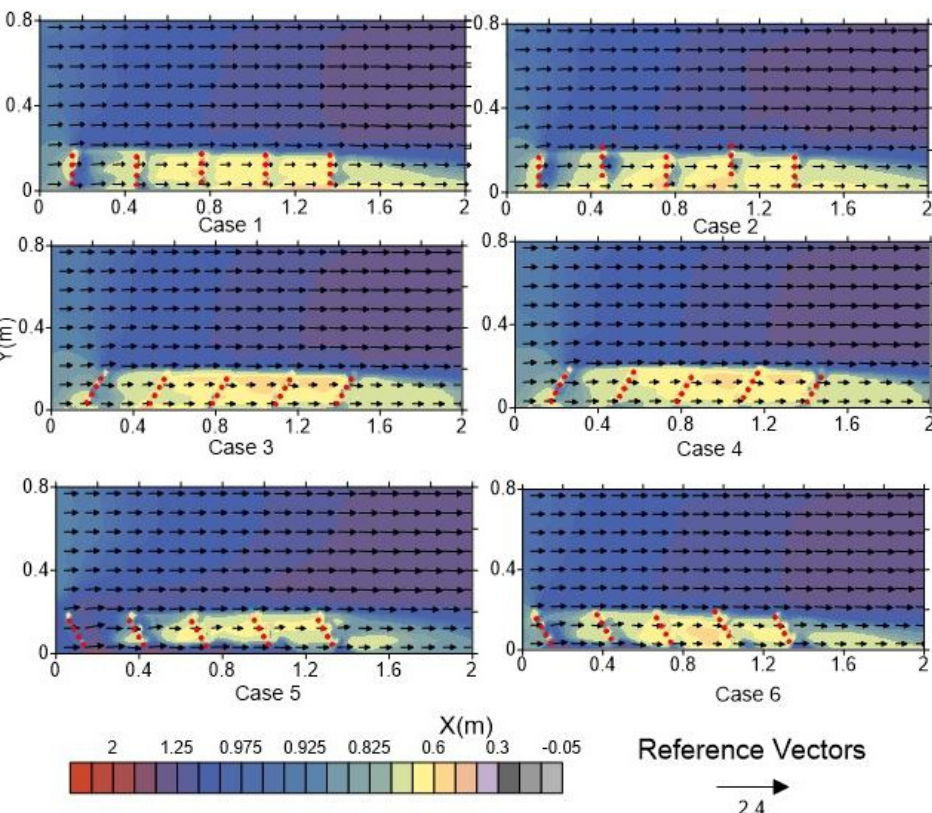
(cid:16) u (cid:17) v , at Z = 0.01 m. The contour shows the variation in the U U (cid:16) u (cid:17) . U